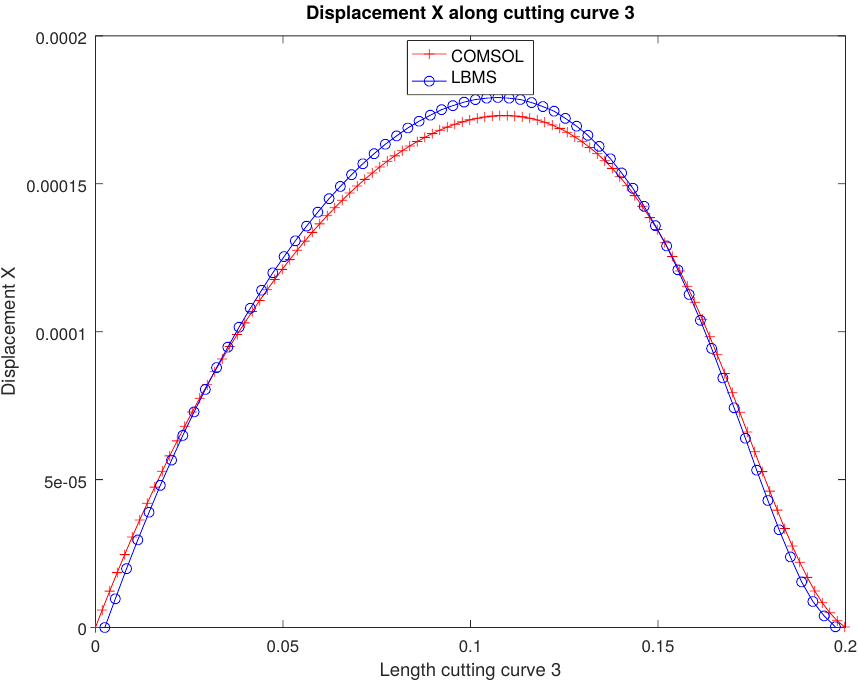
Figure A21. First displacement components along cutting curve C 3 for case E = 200 GPa, ν = 0.15 with triangular loading.